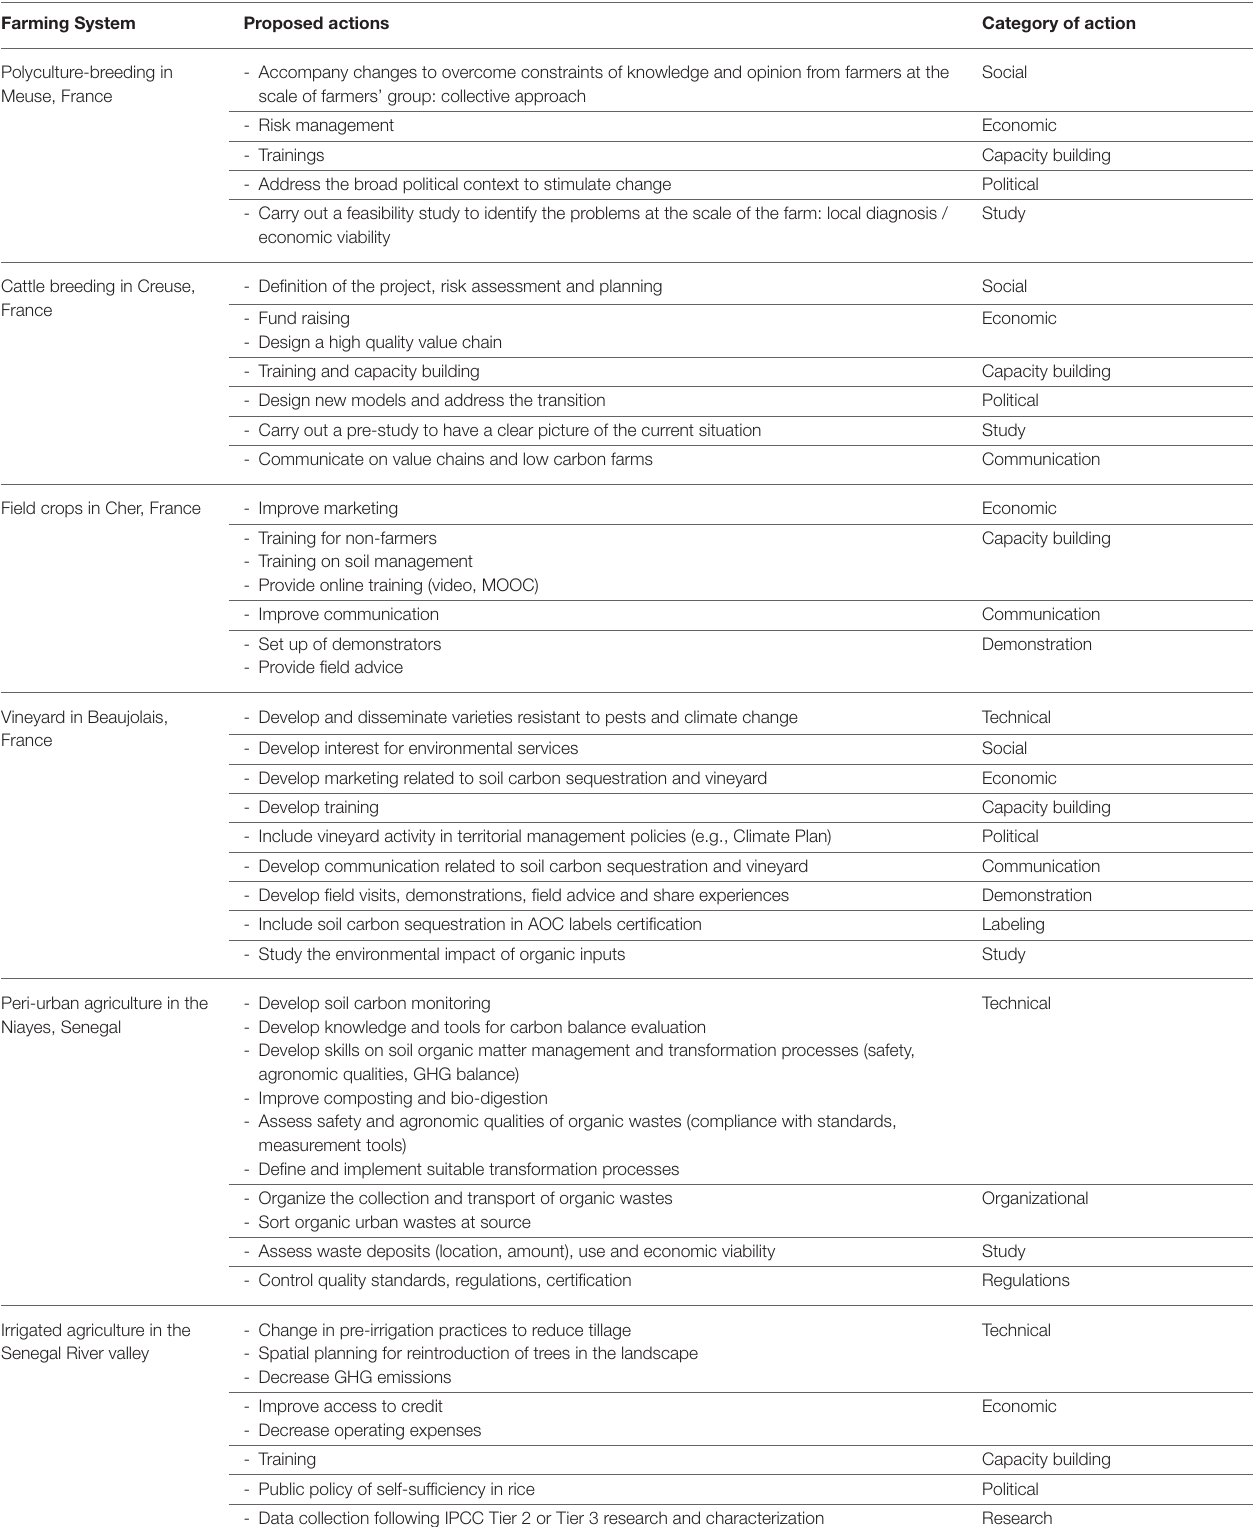
TABLE 4 | Identified actions to overcome barriers to soil organic carbon sequestration in eight different farming systems in France and Senegal (see Table 2 for corresponding practices and barriers). Farming